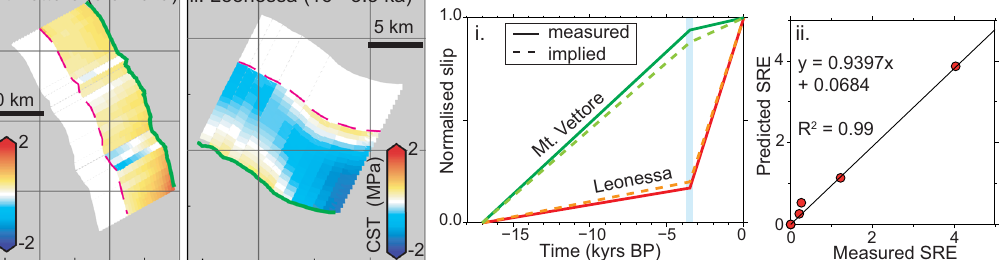
measured sliphistories from 36 Cl and slip histories inferred from differential stress changes and the quartz fl ow law. (i) Slip histories for the Mt. Vettore and Leonessa faultsnormalizedtothetotalmeasuredslip.(ii)SlipRateEnhancement(SRE)values are calculated relative to the long-term (15±3 kyr rate) slip rate, where SRE <1 implies a slowing of slip and a reduction in activity. The similarity between mea- sured and implied slip histories suggests the approach we use, combining stress changes with quartz fl ow laws, to generate the implied slip histories replicates the natural